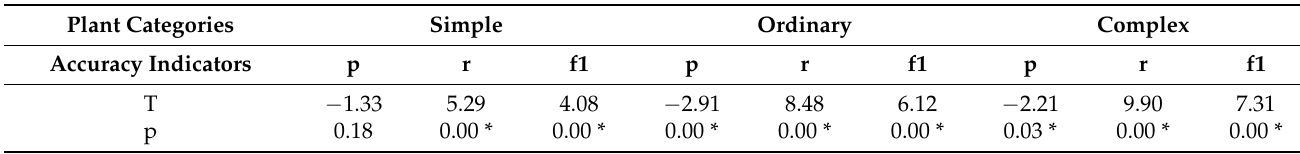
MSTVM-based region-growing algorithm.